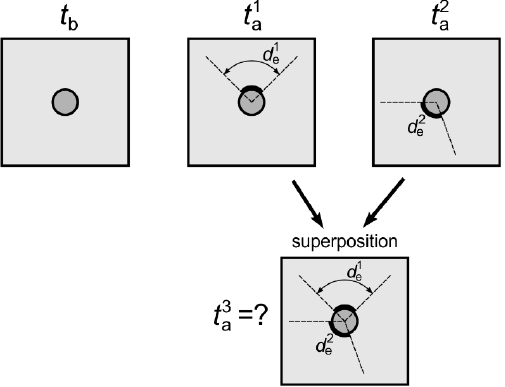
Figure 13. Scheme of specimen with multiple debondings.